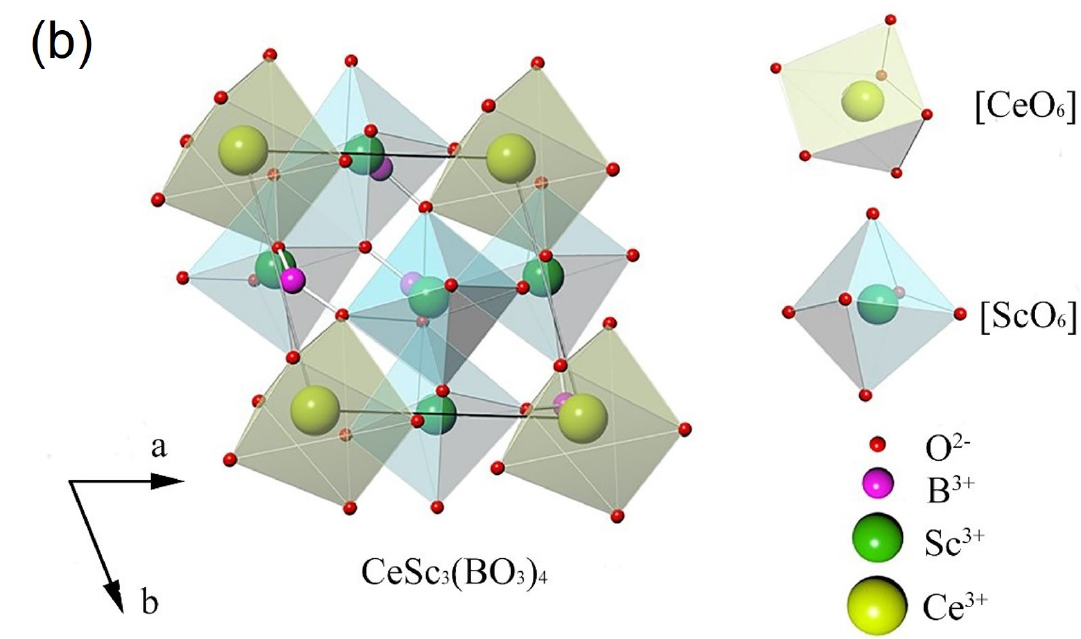
Figure 1. XRD patterns of the RESc 3 (BO 3 ) 4 :Cr 3+ (RE = Ce, Gd, Tb, Lu) phosphors in comparison of the standard CeSc 3 (BO 3 ) 4 pattern with PDF# 38-0720 ( a ), the three-dimension structure of CeSc 3 (BO 3 ) 4 and local coordination of Ce and Sc atoms in the CeSc 3 (BO 3 ) 4 crystal lattice ( b ), and the splitting of Cr 3+ 3d orbital in an octahedral polyhedron based on the Tanabe–Sugano diagram ( c ). The scanning electron microscope (SEM) image presented in Figure 2 shows that the particles of CeSc 3 (BO 3 ) 4 :Cr 3+ phosphor have a typical size of 2–10 μ m, consisting of several small grains that have agglomerated together. Nonetheless, the characteristic trigonal pro- file of the grains could still be identified from the irregular particles, as indicated by the arrow in Figure 2.